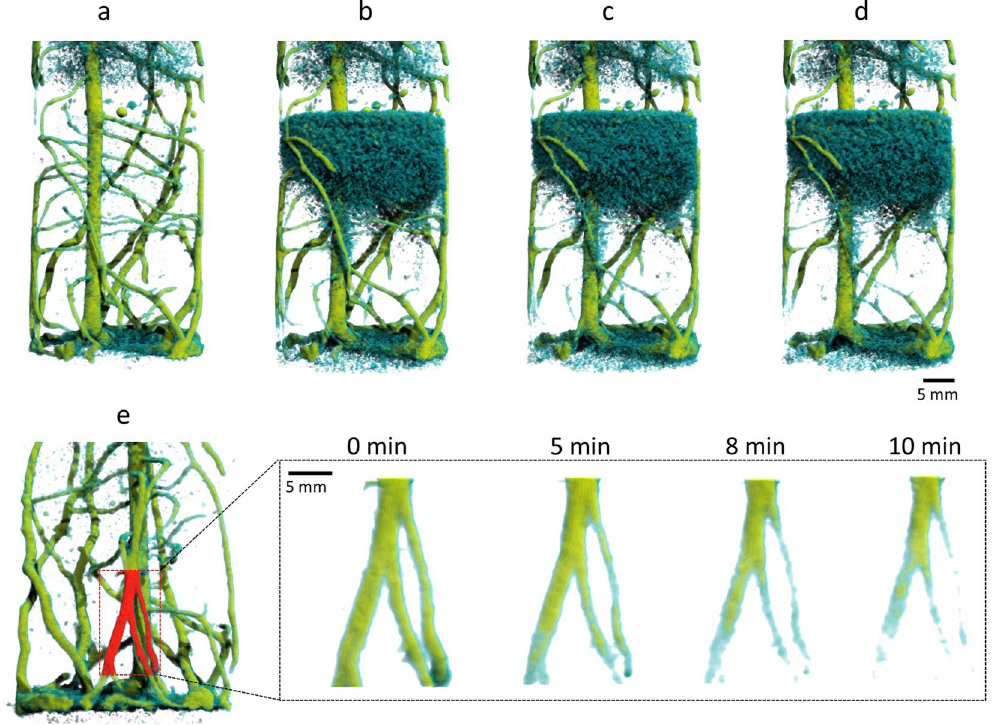
Figure 5. Time series of neutron tomograms showing the lower soil compartment of the plant container at ( a ) 0 min; ( b ) 5 min; ( c ) 8 min ( d ) 10 min after feeding D 2 O through the bottom plate. In the bottom row three lateral root segments are selected (area indicated in e ) and shown as a close-up time development. The gradual disappearance of the lower part of the lateral roots indicates the uptake of deuterated water by these root